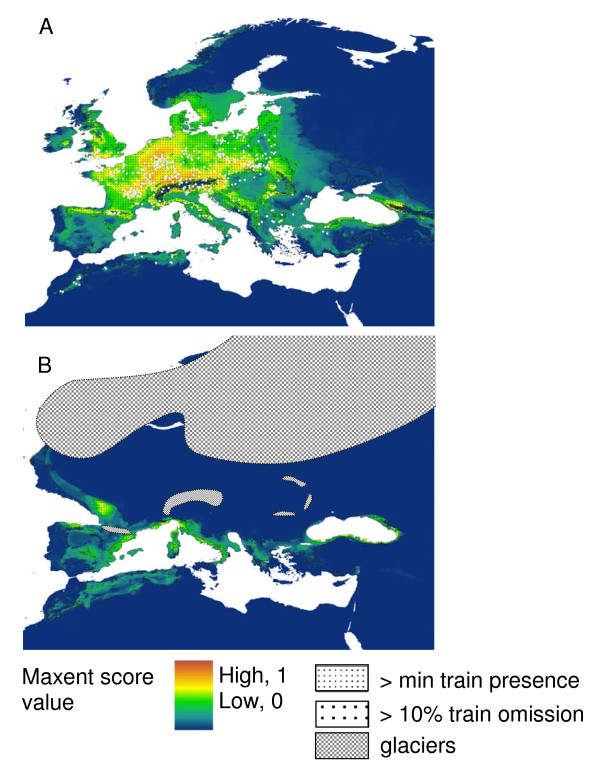
Distribution modelling of Melanargia galathea. Potential distributions of Melanargia galathea under (a) current and (b) palaeoclimatic conditions (CCSM). Species records used for model training are indicated as white dots (3a). Dark grey areas refer to occurrence probabilities above the average minimum training presence; black areas represent those above the 10 percentile training omission.